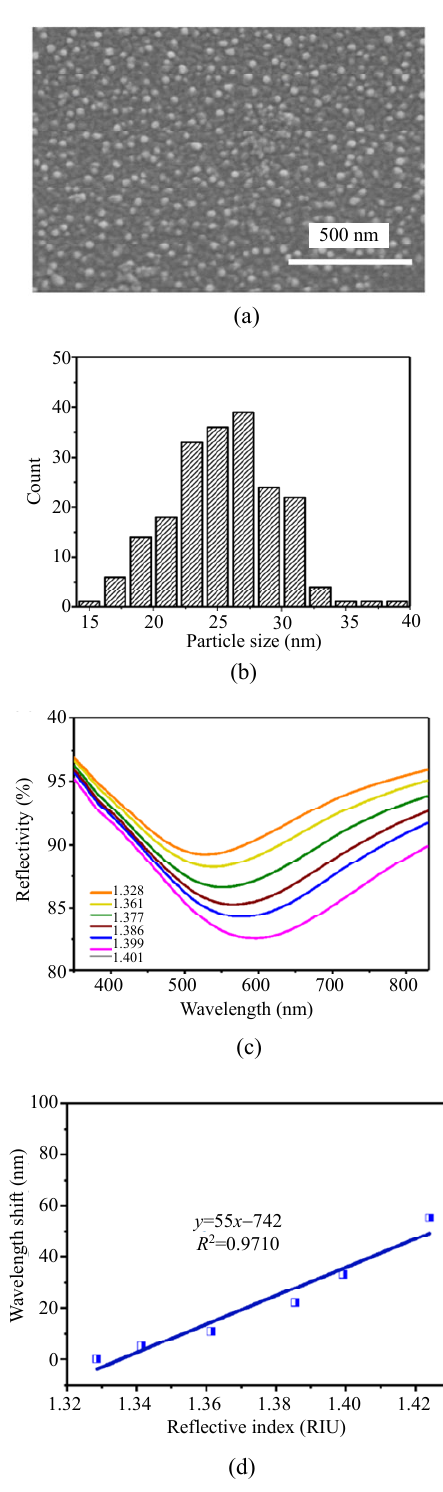
Fig. 2 Characterizations of the as-prepared sensor: (a) SEM images of Ag NPs coated on optical fiber, (b) histogram showing the corresponding particle size distribution of Ag NPs, (c) the reflective spectra of the PDA/Ag-based LSPR sensor in different alcoholic solution, and (d) changes in the LSPR wavelength shift of the as-prepared sensor to the